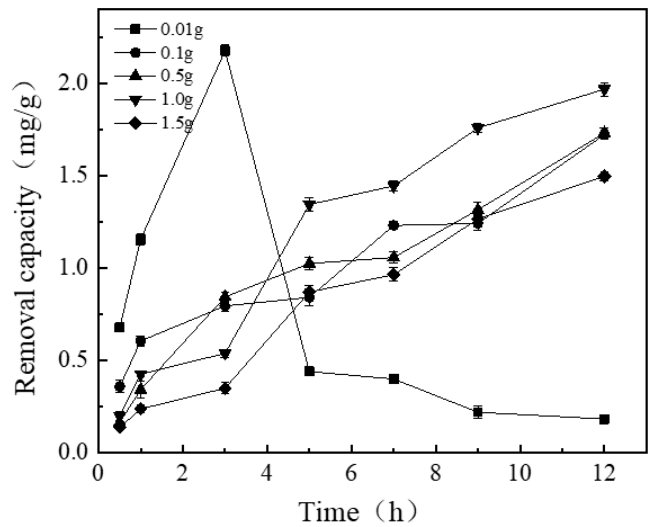
Table 1. Significance analysis of variance.